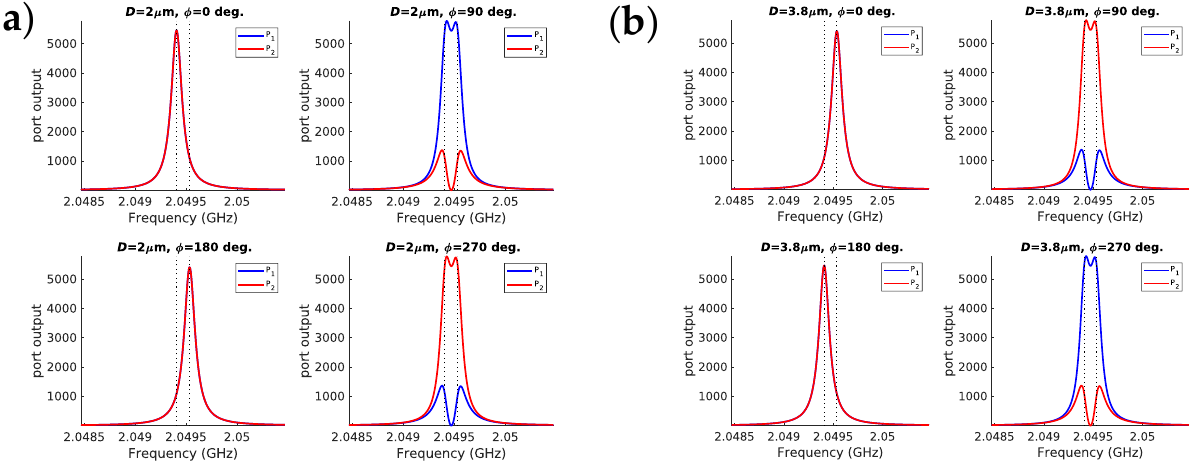
Figure 9. Outputs at ports P 1 and P 2 in shape B with D = 2 µ m ( a ) and 3.8 µ m ( b ) under the excitation of two sources at four fixed temporal phase shifts.